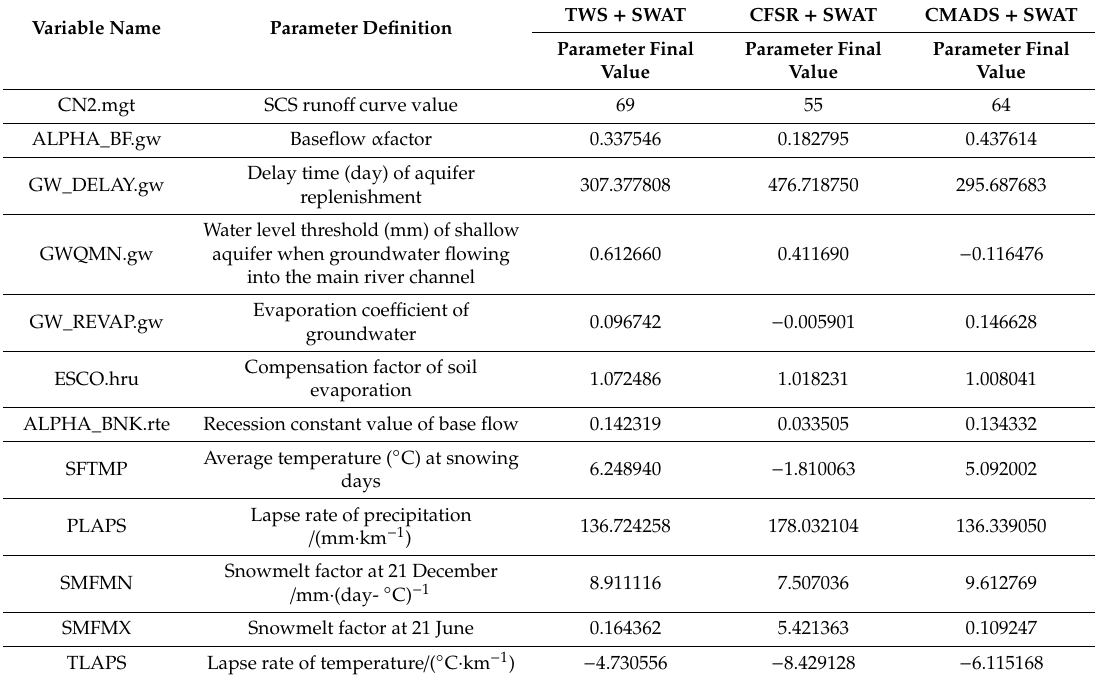
Table 4. Final value of Soil and Water Assessment Tool (SWAT) model